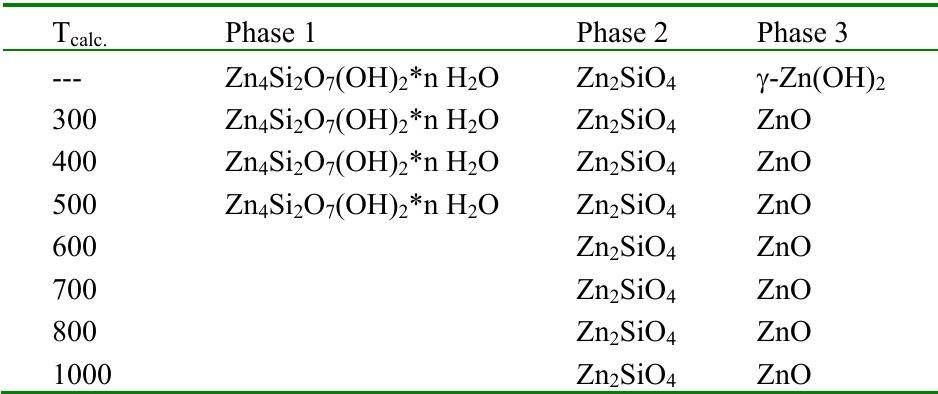
Table 1 . Crystal structures as a function of calcination temperature T XRD and